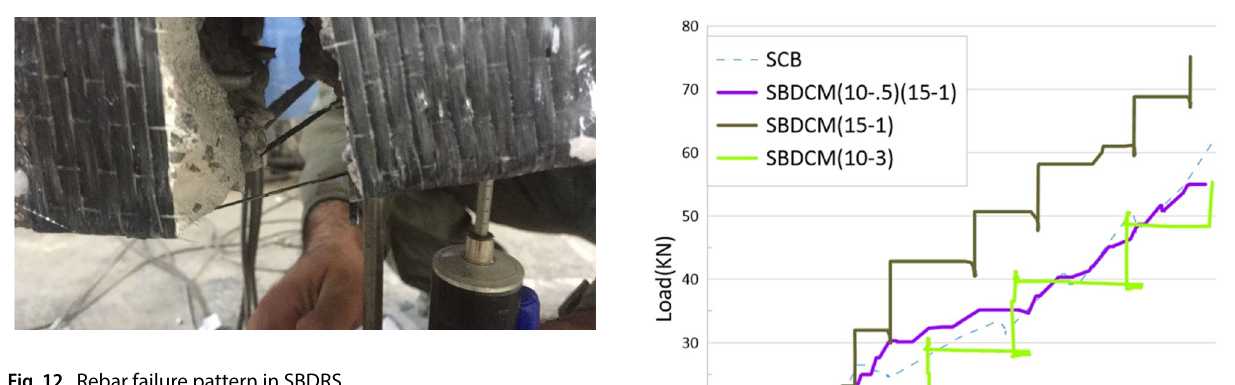
Fig. 12 Rebar failure pattern in SBDRS